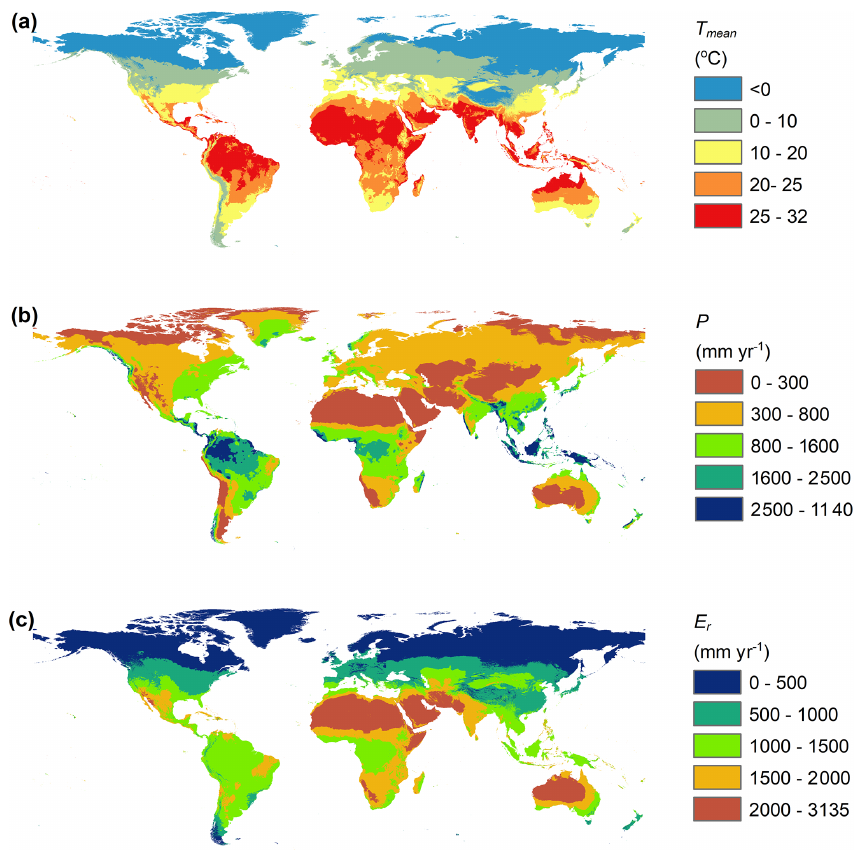
Figure 1. (a) Mean annual temperature for the period (Hijmans et al., 2005), (b) mean annual precipitation for the period (Hijmans et al., 2005), and (c) mean annual reference evapotranspiration of ASCE-standardized method for short reference crop for the period (Aschonitis et al., 2017) of